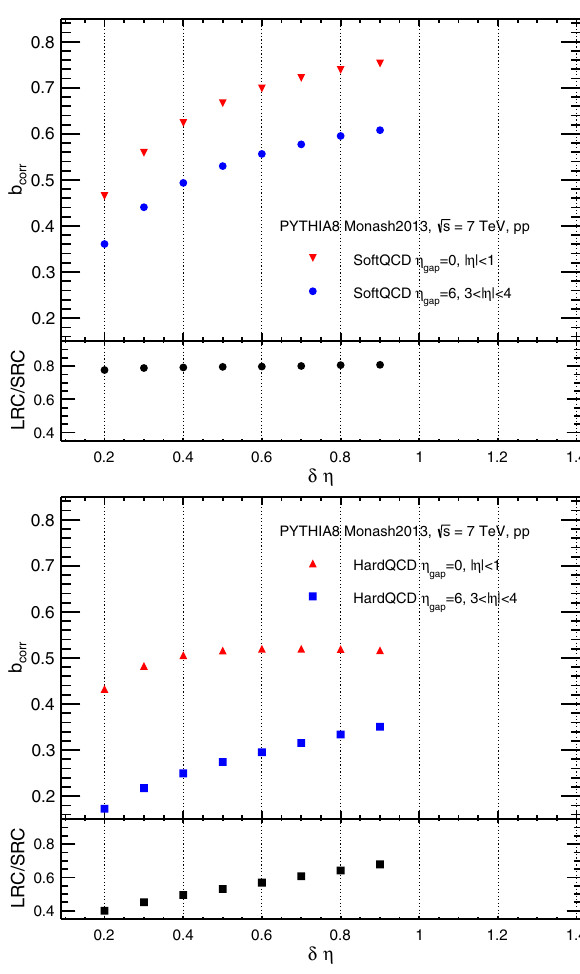
√ s = 7 TeV for soft